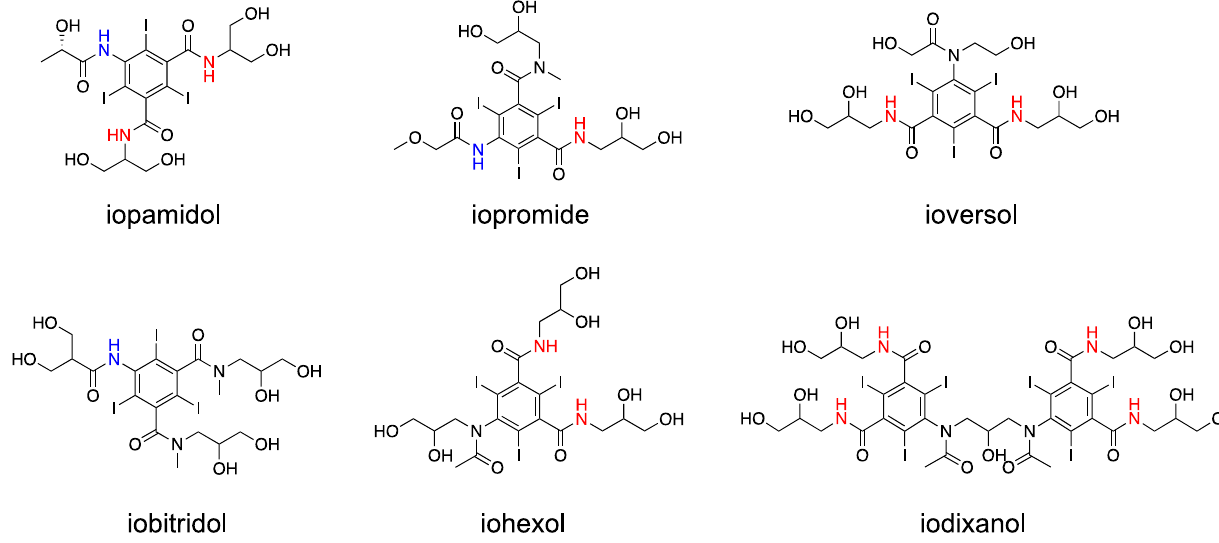
Figure 1. Chemical structures of X-ray/CT contrast agents that have been investigated for CEST MRI studies. Because of the different chemical environments, the amide protons may have different chemical shifts, which are indicated in different colors.